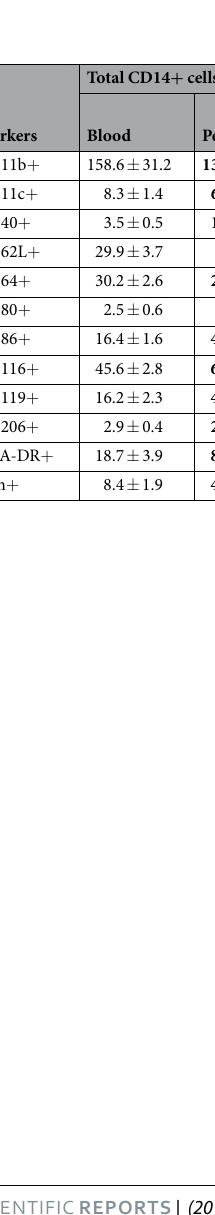
6 SCIENtIFIC REPoRTS | (2018) 8:12794 | DOI:10.1038/s41598-018-30787-x